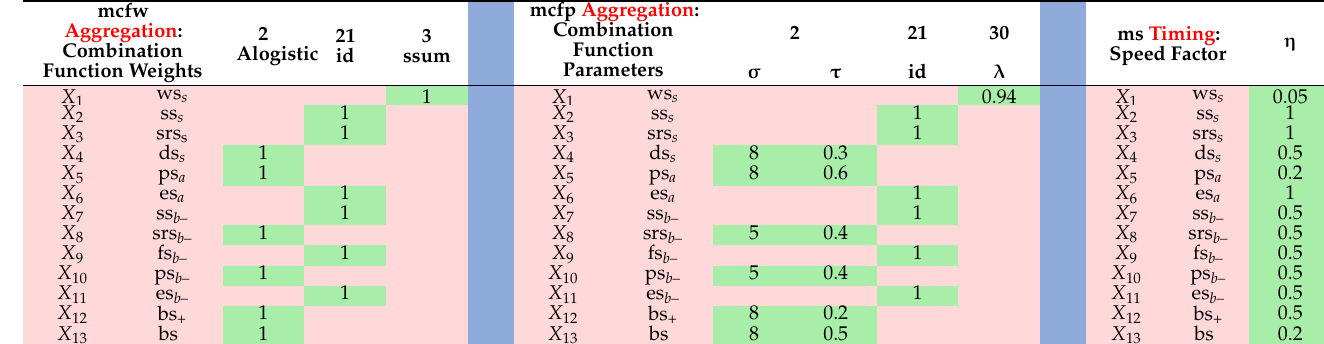
Table A2. Role matrices for aggregation and